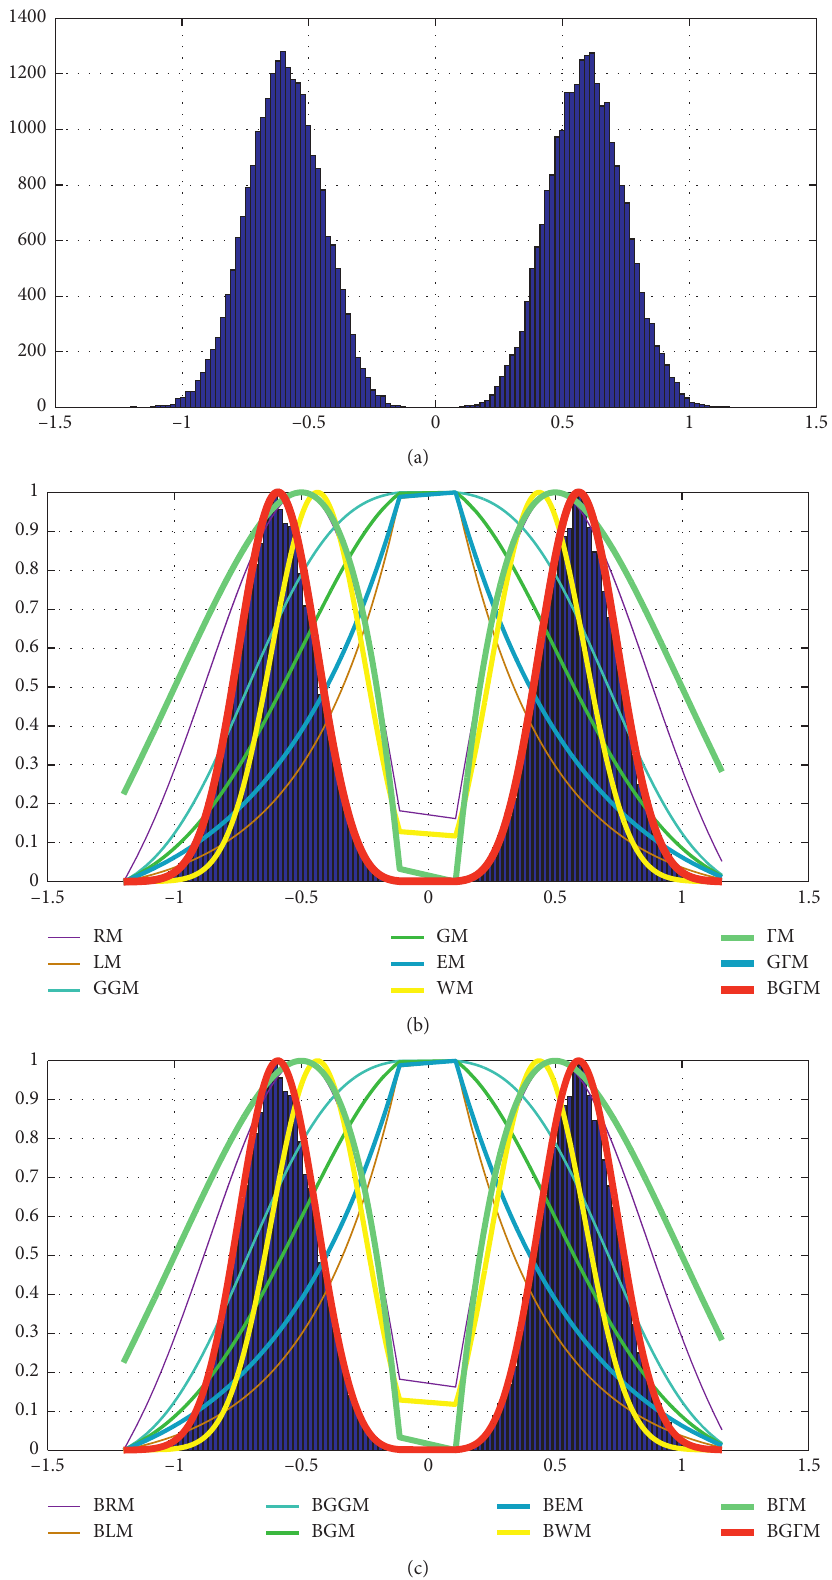
Figure 5: The estimated histogram. (a) The histogram of the observed data with u � 0; δ � 0 . 5; η � 2, λ � 3 and β � 1 in the interval (− 1 . 5 , 1 . 5 ) ; (b) the estimated histogram of RM, LM, WM, GM, EM, GGM, Γ M, G Γ M, and G Γ M; (c) the estimated histogram of BRM, BLM, BWM, BGM, BEM, BGGM, B Γ M, and BG Γ